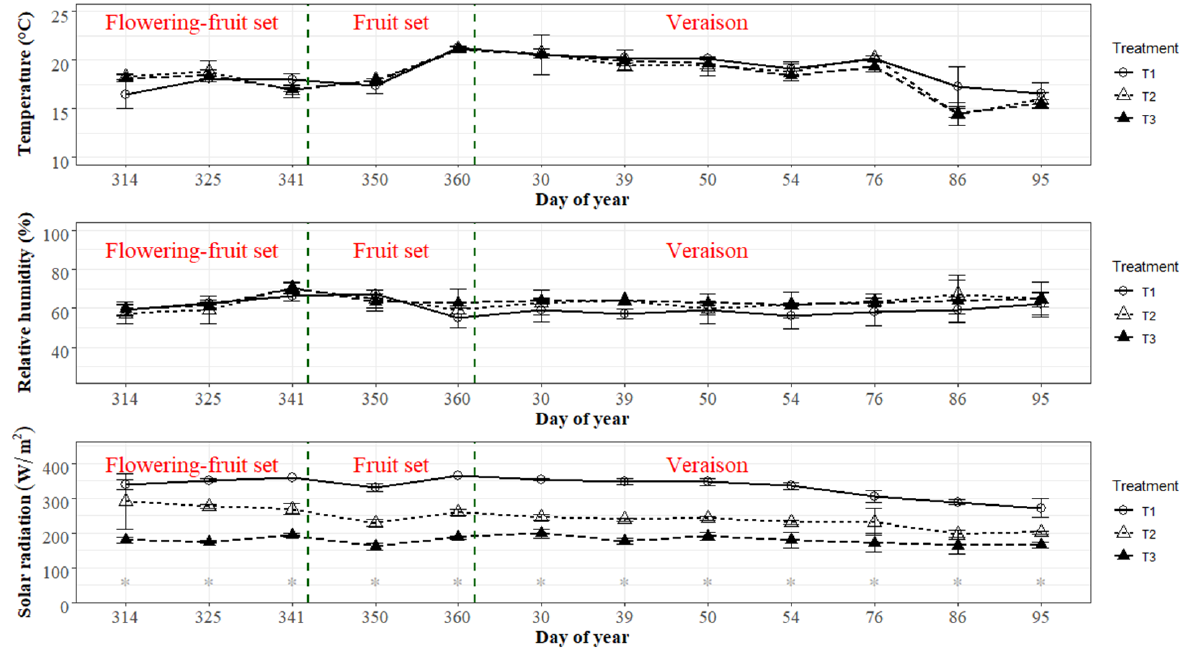
Figure 1. Seasonal pattern of temperature (°C), relative humidity (%), and solar radiation (W m 2 − 1 ) along the flowering-fruit set, fruit set; and veraison stages for control (T1), white shading net (T2) and black shading net (T3), during 2006–07 season. * Significant differences (Tukey’s test, p -value ≤ 0.05).